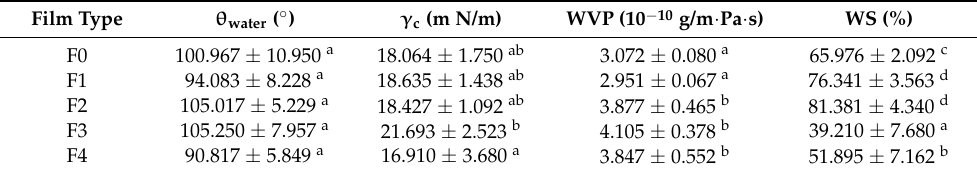
Table 2. The water contact angle ( θ water ), critical surface tension ( γ c ), water vapor permeability (WVP), and water solubility (WS) of bionanocomposite and control